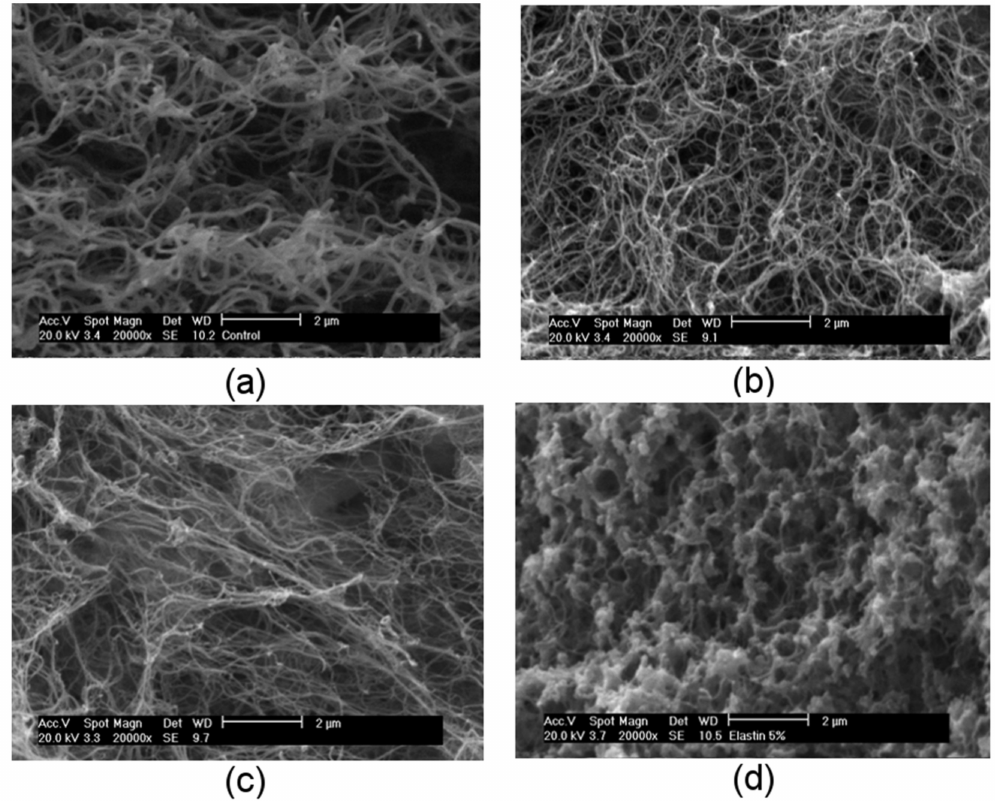
Figure 3. Scanning electron microscopy (SEM) images of ( a ) plasma and elastin-plasma hydrogels with ( b ) 1%, ( c ) 3% and ( d ) 5% elastin concentration after 10 days of incubation in PBS at 37 ◦ C, at 20,000 × magnification and an accelerating voltage of 10 kV. Scale bar corresponds to 2 µ